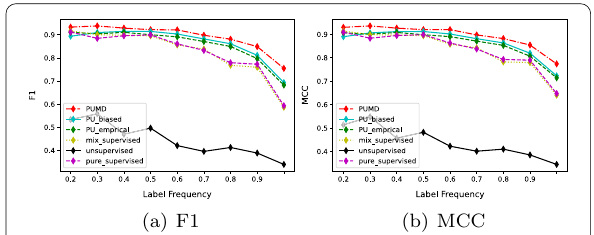
Fig. 8 PUMD and multiple comparison algorithms performance evaluation. ( a ) Prediction F1 changes. ( b ) Prediction MCC